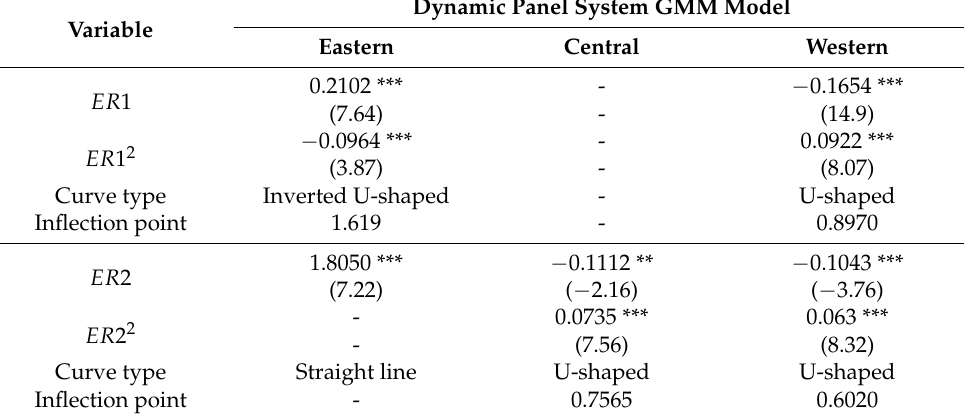
Table 5. Regional regression